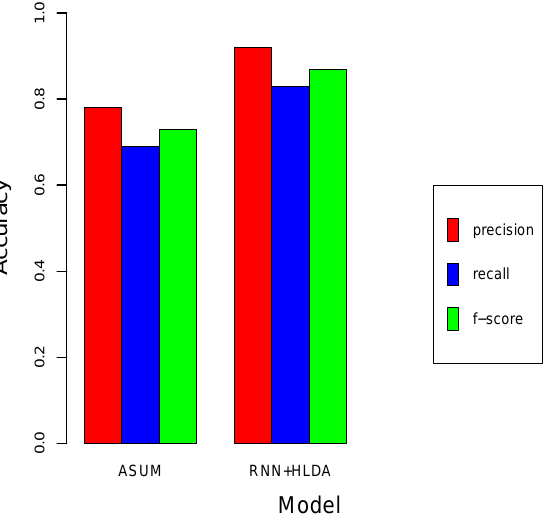
Figure 4. The feature-dependent sentiment analysis comparison under the joint model and